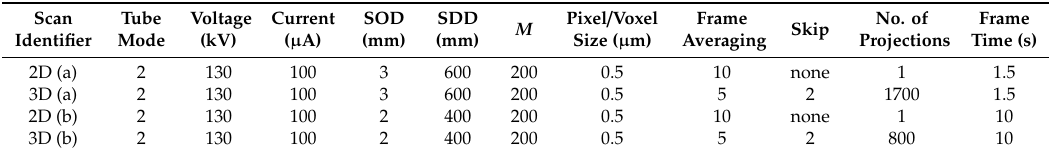
Table 1. Summary of experiments and their image acquisition